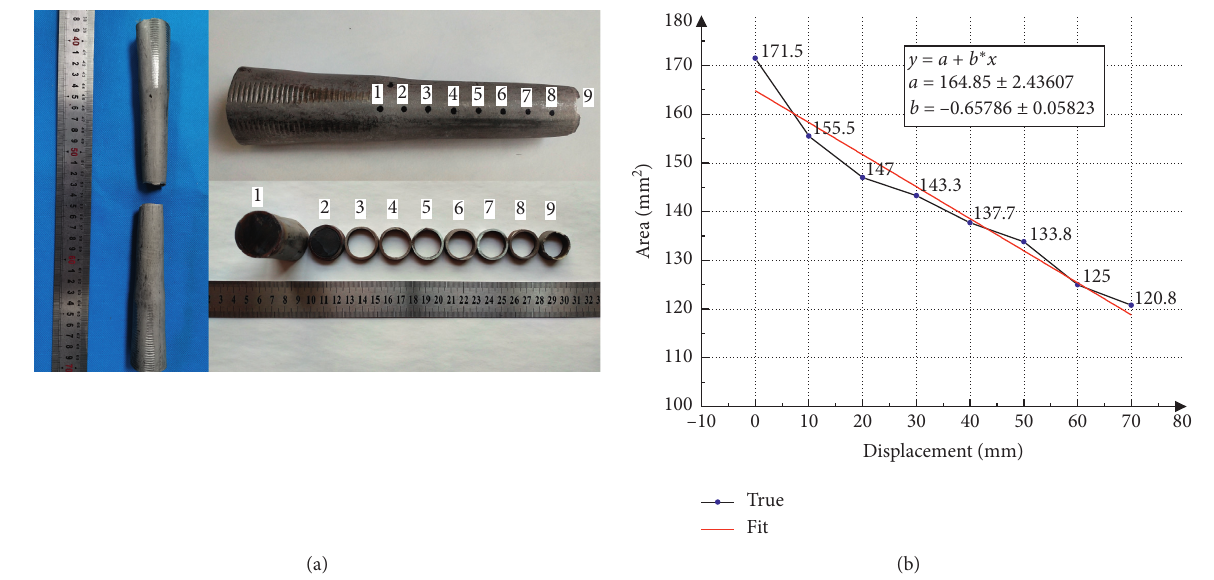
Figure 7: The morphology (a) and change curves (b) for the cross-sectional area of the standard specimen after the fracture. Note. R -square of the fitted straight line is 0.94761.